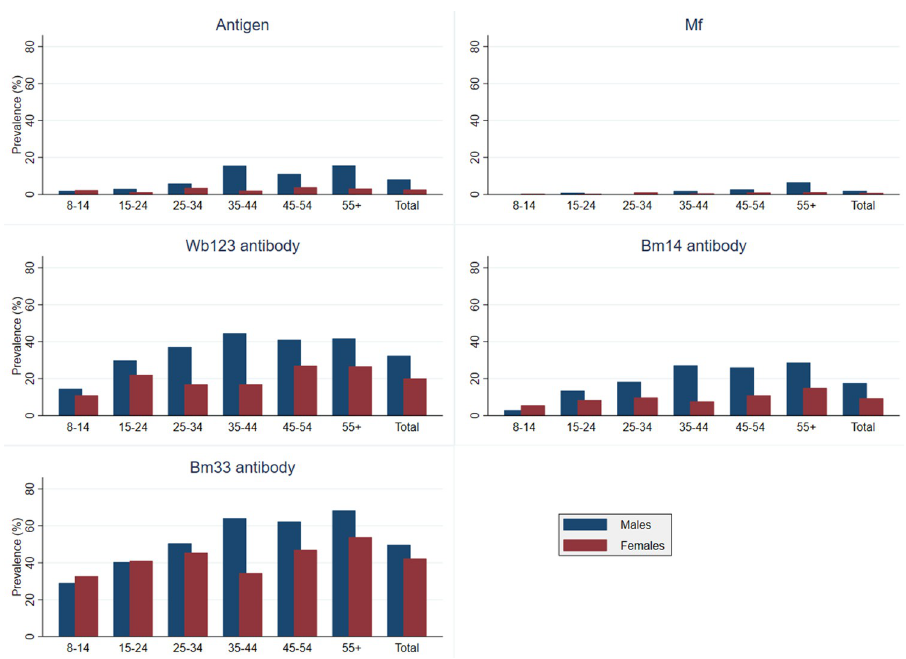
Fig 1. Seroprevalence of lymphatic filariasis infection markers stratified by age and gender, American Samoa 2016.